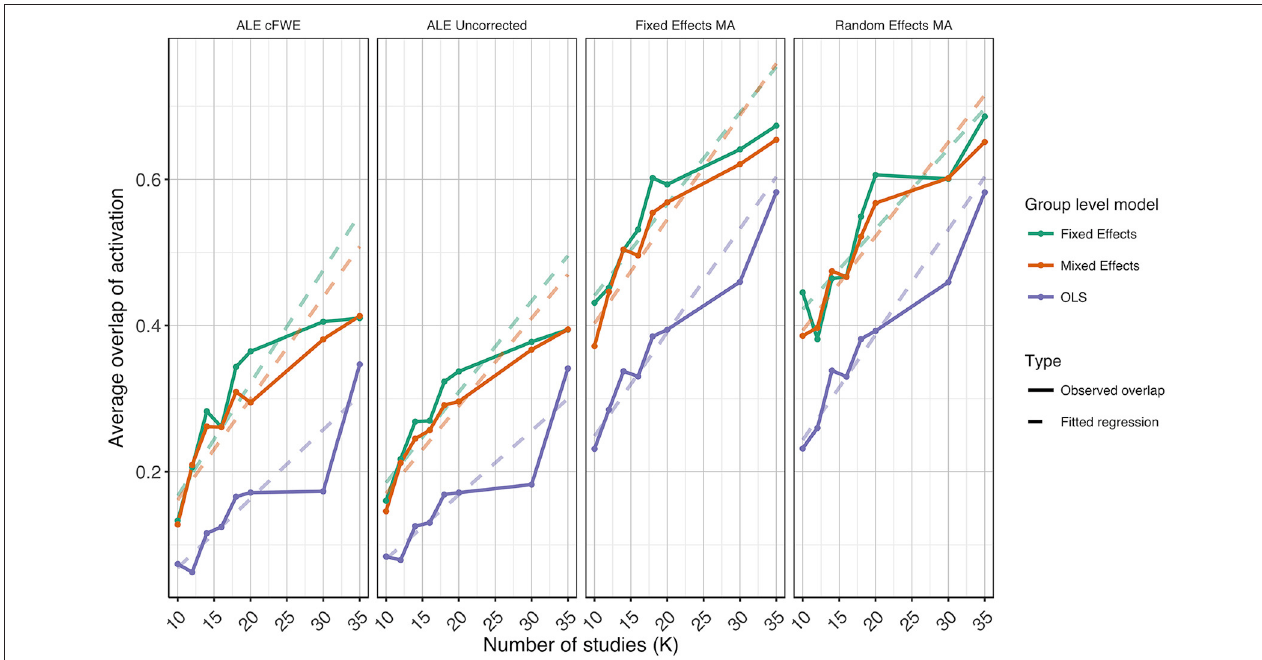
FIGURE 10 | Values of the percent overlap of activation, averaged over all folds for all K . The 4 panes correspond to the methods of CBMA (after significance testing) while the three colors correspond to the group models. Solid lines are the observed values of overlap. The dashed lines correspond to the fitted regression lines.